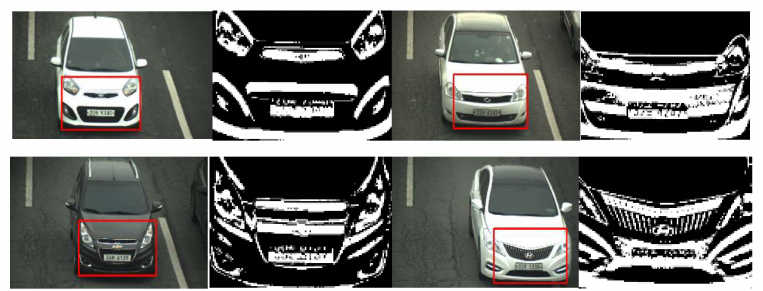
Figure 7. Results of frontal-view extraction on five vehicle images featuring four companies and four models.